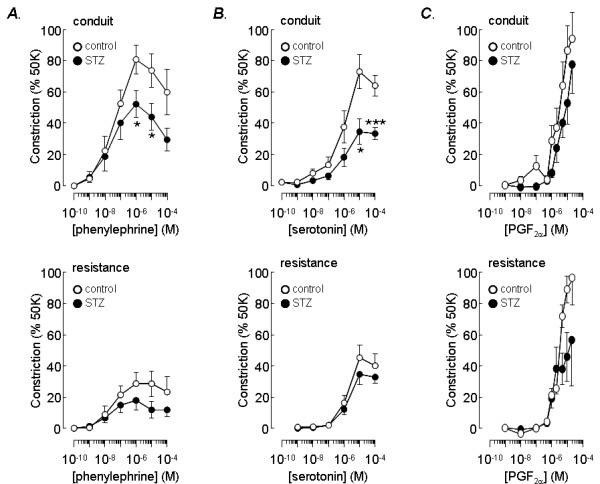
Effect of STZ-induced diabetes on responses to vasoconstrictor agonists. Concentration response curves for vasoconstriction evoked by phenylephrine (A), serotonin (B) and PGF2α (C) in conduit (upper panels) and resistance (lower panels) arteries. Responses were measured as a percentage of the constriction induced by 50 mM KCl and are shown for STZ-treated, diabetic (solid circles) and age-matched control rats. Data plotted are mean ± s.e.m. with n = 12–13 (phenylephrine), n = 12 (serotonin) or n = 3–10 (PGF2α). *P < 0.05, ***P < 0.001 versus control.